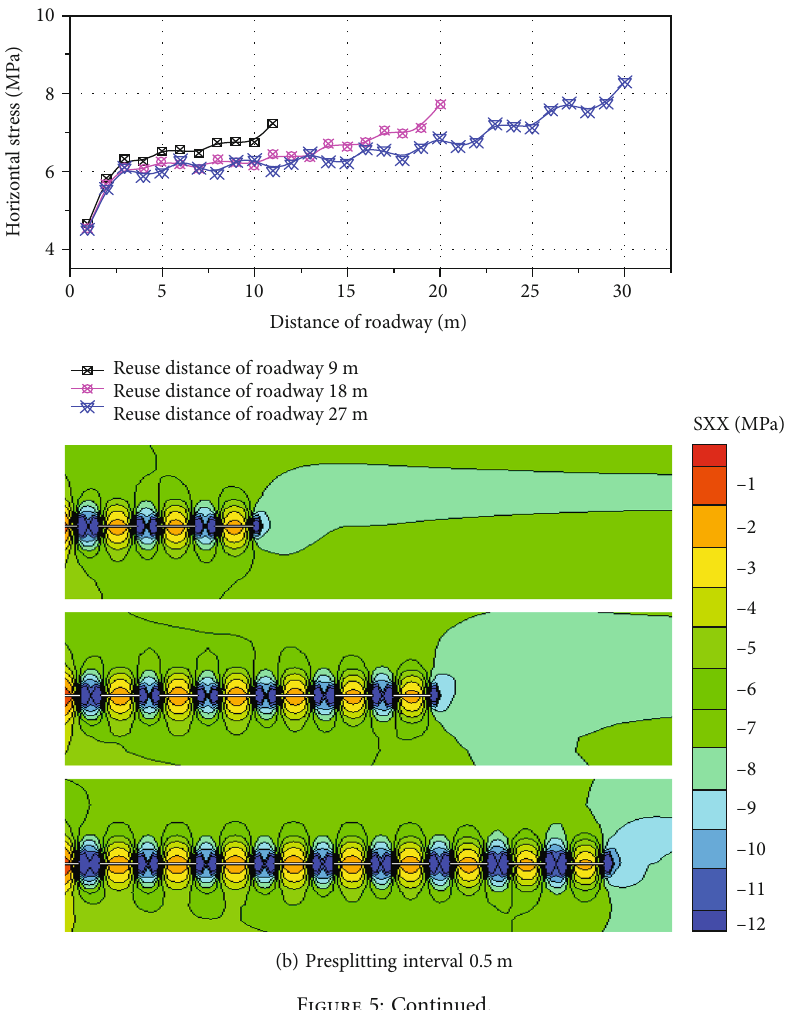
(b) Presplitting interval 0.5m Figure 5: